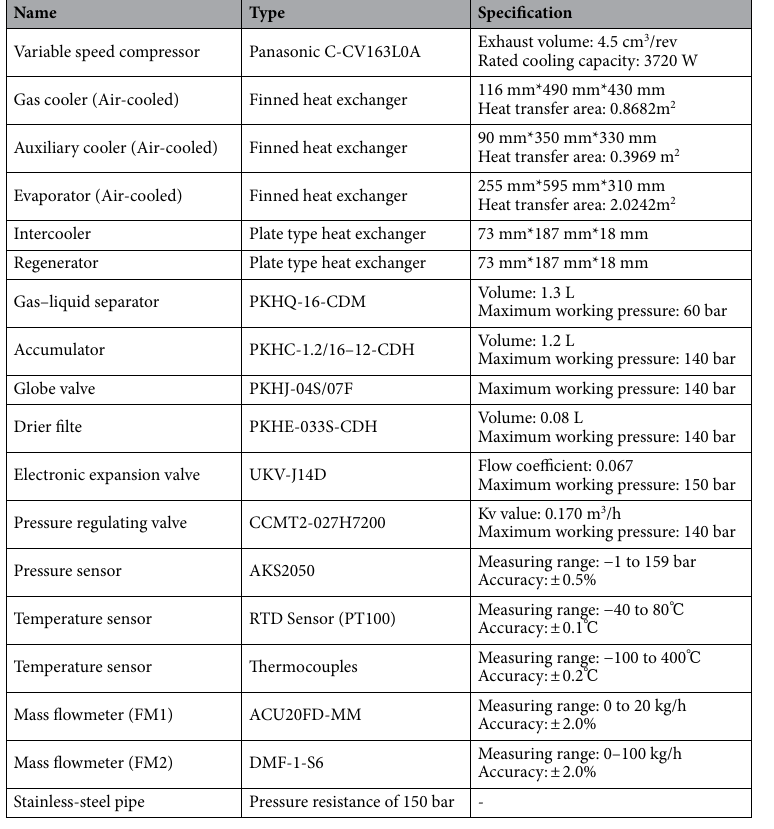
Table 1. The devices of the CO 2 transcritical refrigeration experimental